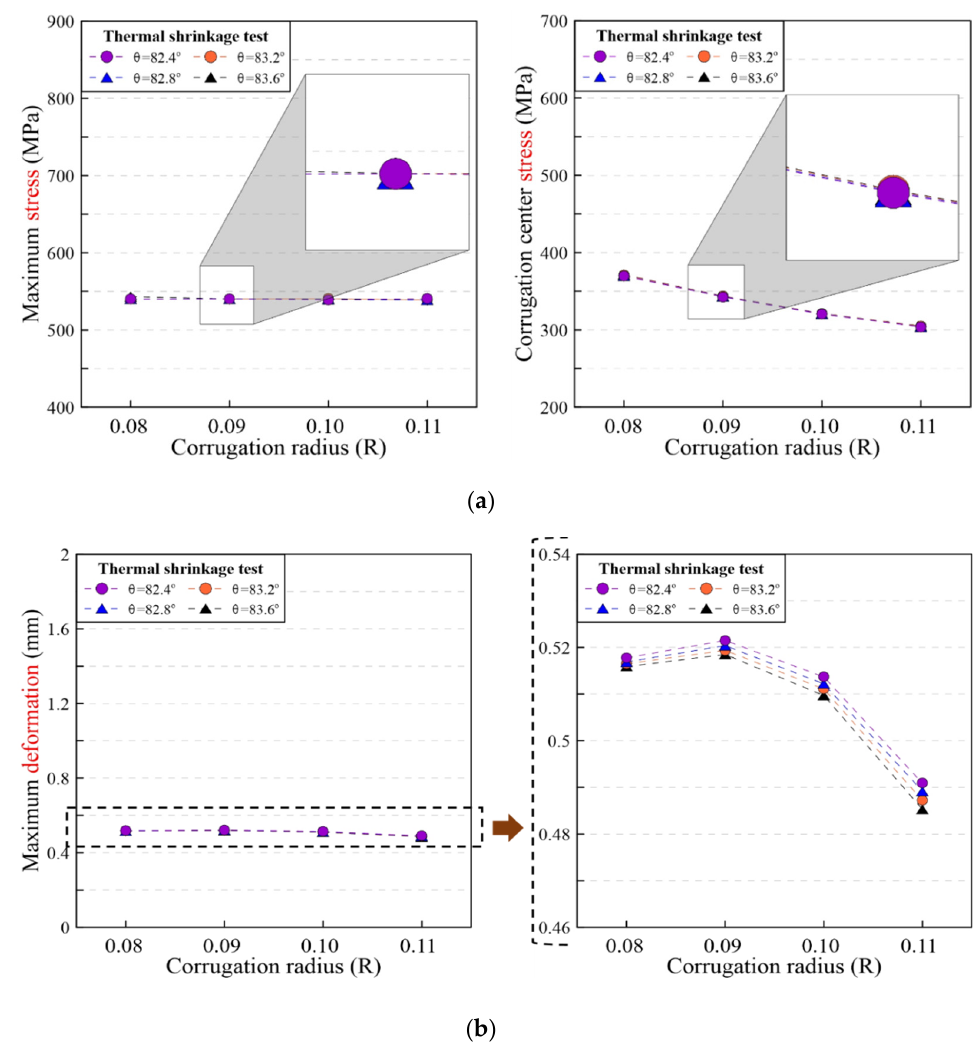
( d ) Figure 13. Maximum ( a ) stress, stress on the center corrugation, and ( b ) deformation of SPB according to the fillet angle in thermal shrinkage analysis. The dashed line represents the enlarged region of the